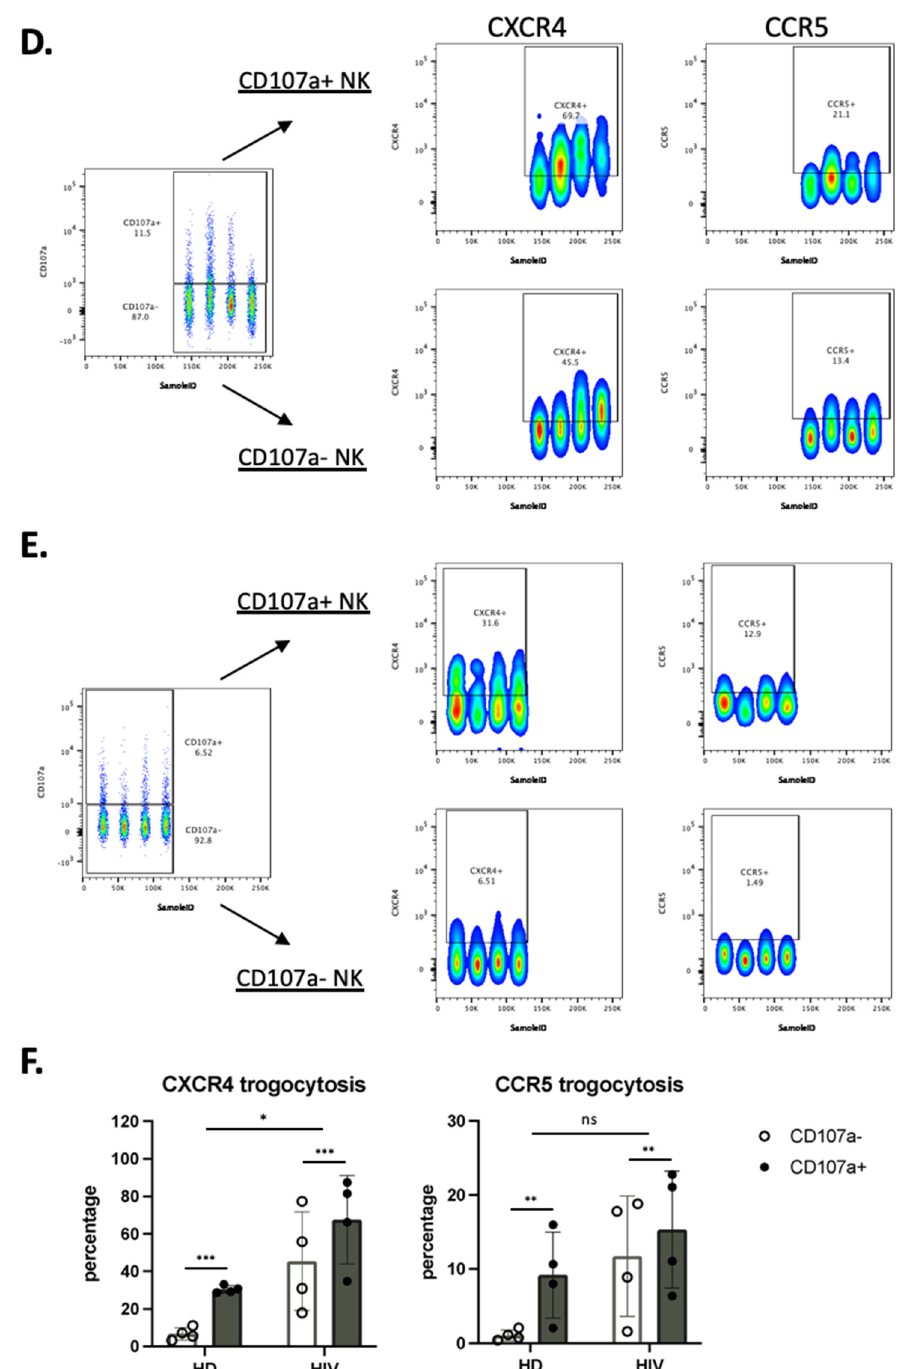
Figure 6. NK cells that have degranulated in viremic HIV-1 + patients performed enhanced trogocytosis. ( A , B ) Comparison of trogocytosis on CD107a + vs. CD107a − on CD56 + NK cells in viremic HIV-1 patients ( A ) and HD ( B ). ( C ) Percentage of CXCR4 and CCR5 expression on CD56 + NK cells expressing or not CD107a. ( D , E ). CD56 − CD16 + NK cells in viremic HIV-1 patients performed enhanced trogocytosis. Comparison of trogocytosis on CD107a + vs. CD107a- on CD56 − CD16 + NK cells in HIV-1 + patients ( D ) and HD ( E ). ( F ) Percentage of CXCR4 and CCR5 expression on CD56 − CD16 + NK cells expressing or not CD107a. Statistical significance was carried by two-way ANOVA between HD vs. HIV-1 and CD107a − vs. CD107a + ; * p ≤ 0.05, ** p ≤ 0.01, *** p ≤ 0.001 and **** p ≤ 0.0001.